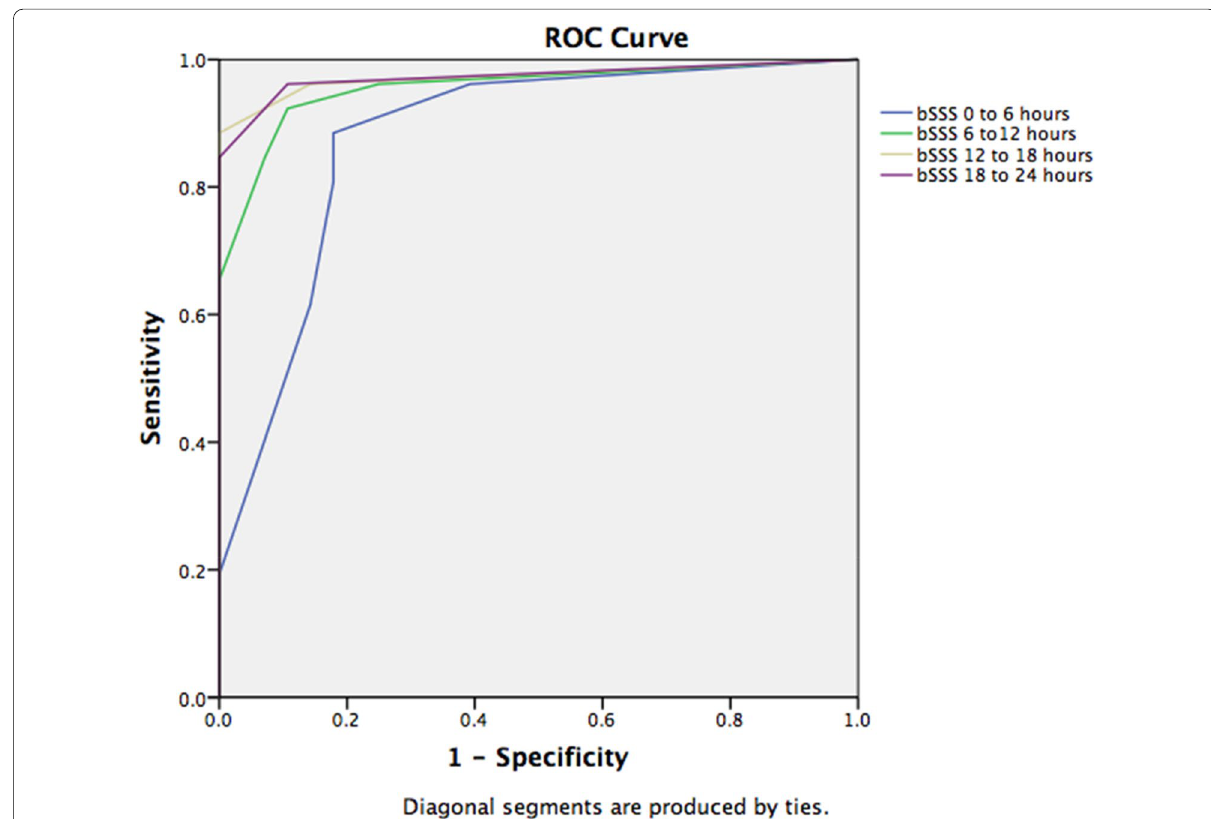
Fig. 3 Receiver operating curve (ROC) and area under the ROC for mortality of bedside Septic Shock Score (bSSS) calculated in the first 24 h following admission for septic